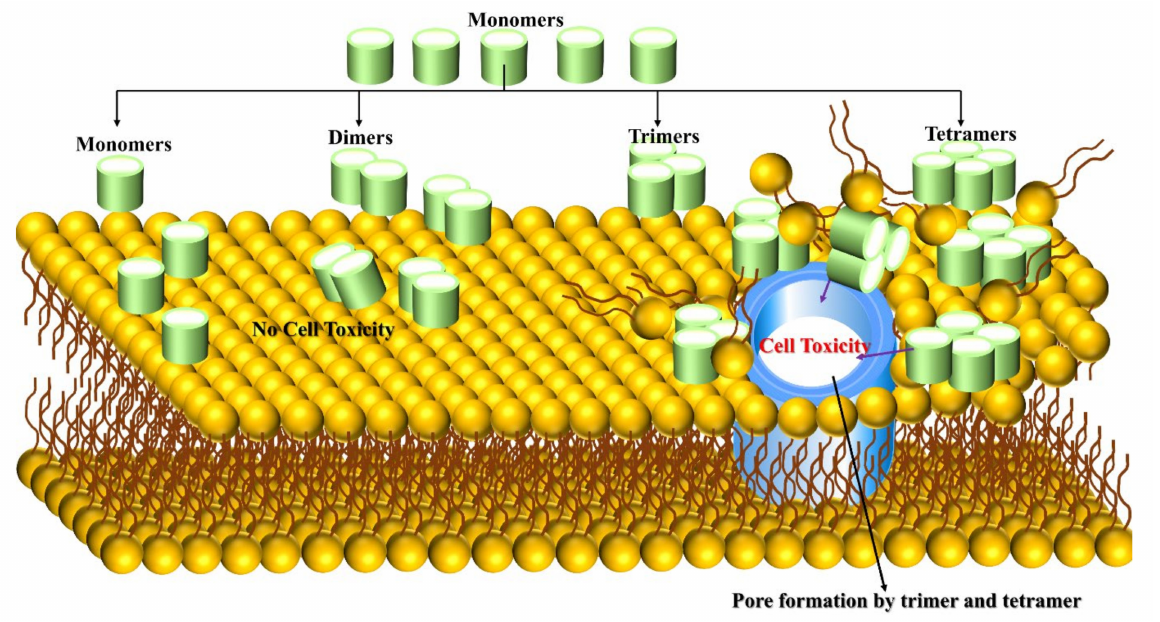
Figure 3. A β monomers and dimers interacting with membrane bilayers do not cause cell toxicity but tetramers followed by trimer binding causes the cell